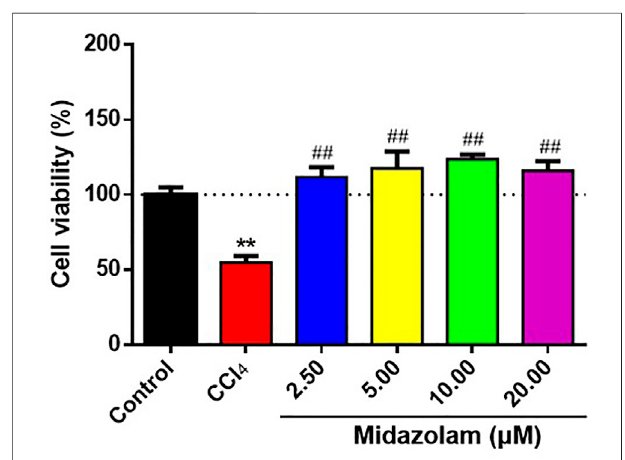
FIGURE 4 | Effects of different concentrations of midazolam on HepG2 cells activity induced by CCl 4 . HepG2 cells were pretreated with different concentrations of midazolam (2.5, 5, 10, 20 Mm) for 24 h. CCl 4 ((IC 50 = 1.5%) induced HepG2 cells injury for 24 h. CCK-8 was used to analyze the effects of different concentrations of midazolam on cell viability induced by CCl 4 .Theresultswereshownasmean±S.D.** p < 0.01vs.thecontrolgroup; ## p < 0.01 vs. the CCl 4